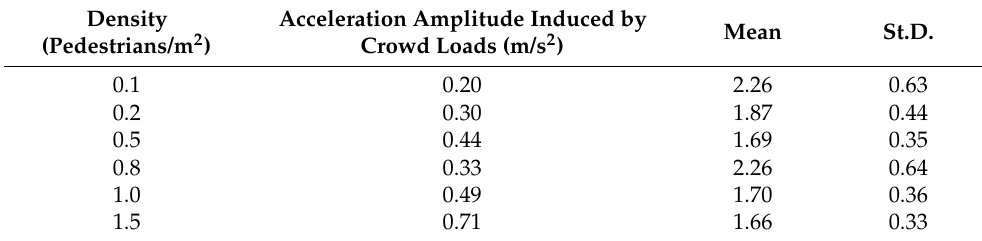
Table 5. Statistical values of amplification factor for different densities in the case of intensity